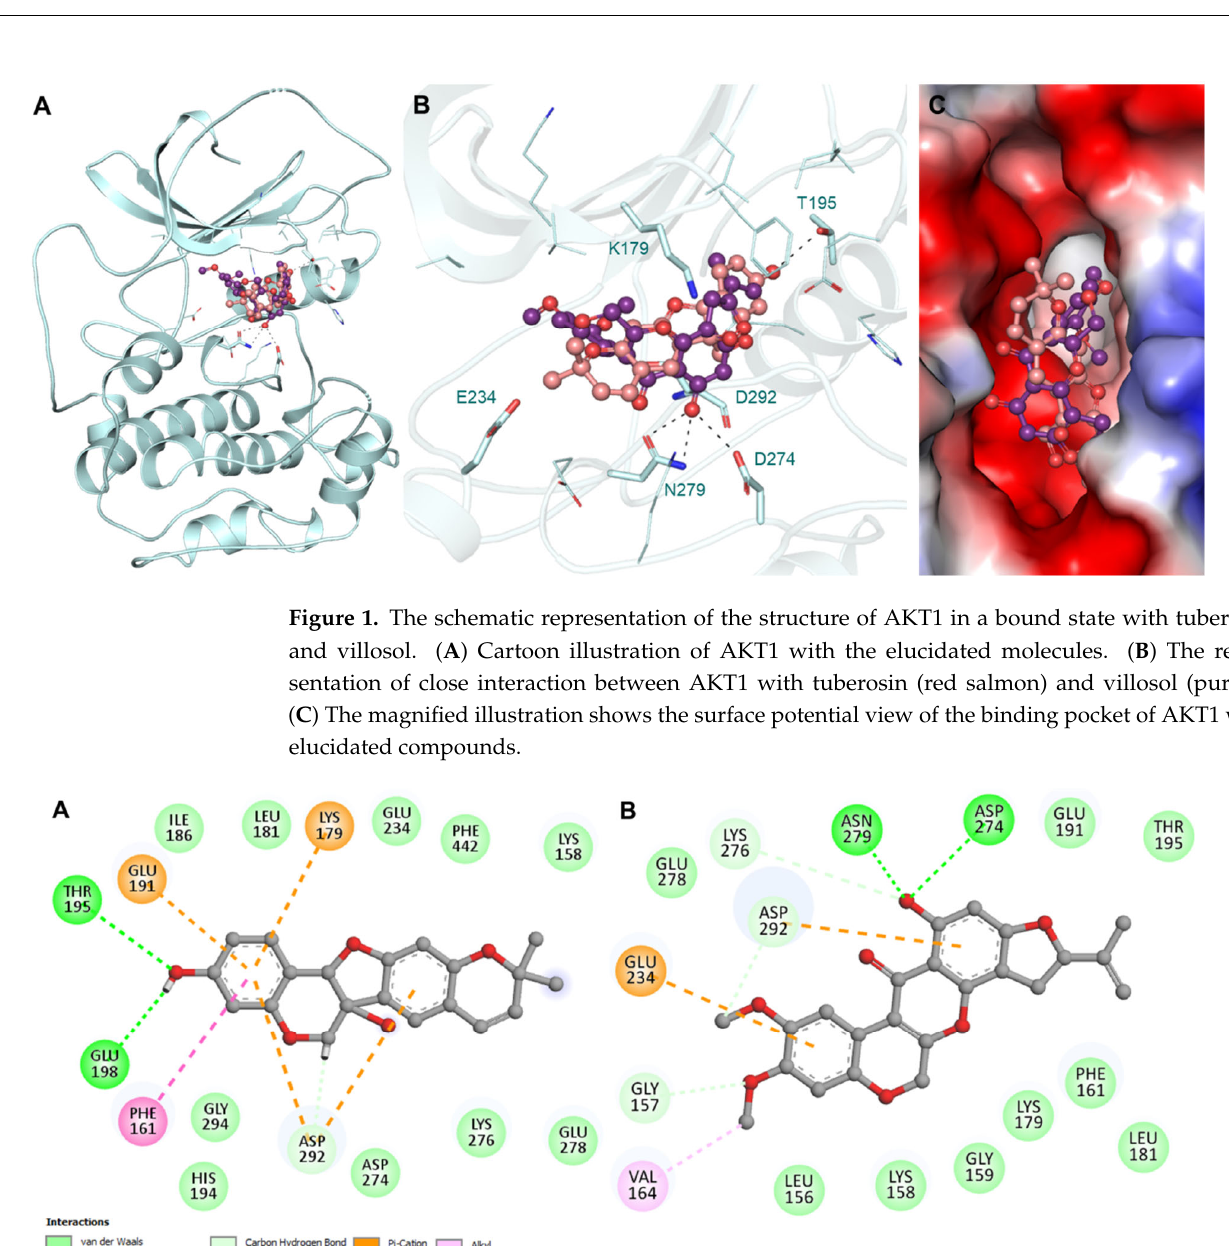
Figure 2. The two ‐ dimensional representation of binding pocket residues of AKT1 and its respective interactions with compounds tuberosin ( A ) and villosol ( B ). The tuberosin shows the noncovalent interactions formed between the active site and ATP ‐ binding residues of protein AKT1. The hydro ‐ gen bonds are formed between sites Lys179, Glu191, and Asp 292. The villosol shows noncovalent interactions between crucial residues of protein Glu234 and Asp292, with target protein AKT1.